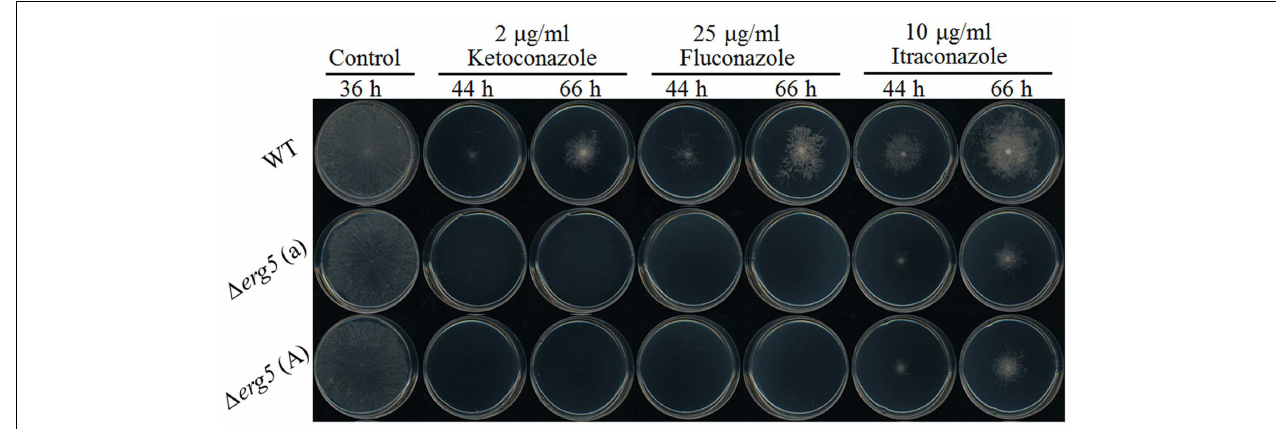
without antifungal drugs, then incubated at 28˚C for 66h. Each test had three replicates and the experiment was independently repeated